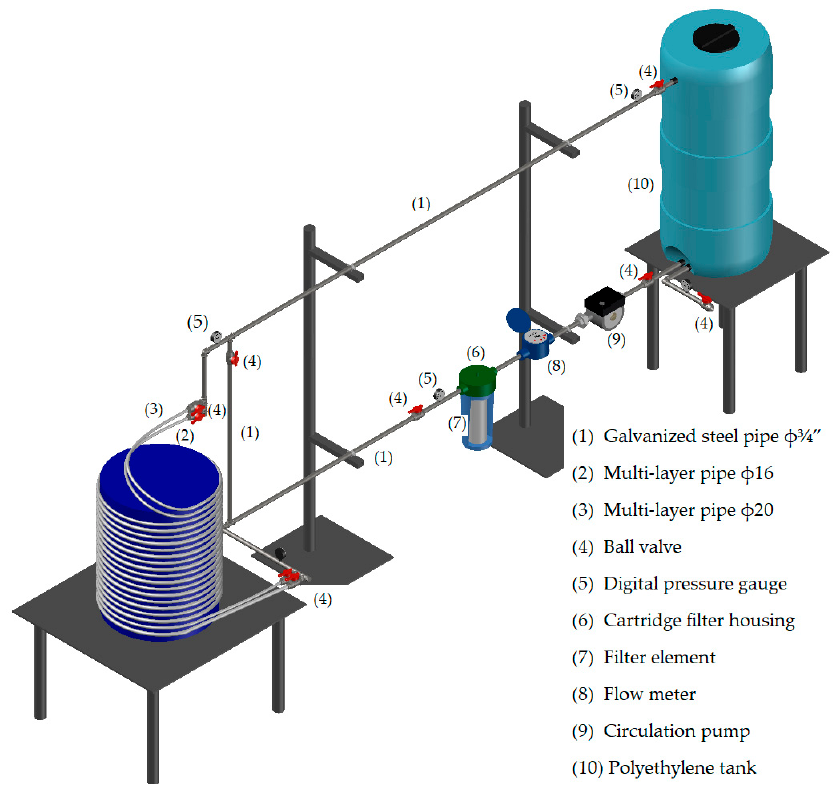
Figure 3. Sketch of the pilot circuit adopted for the laboratory experiments.